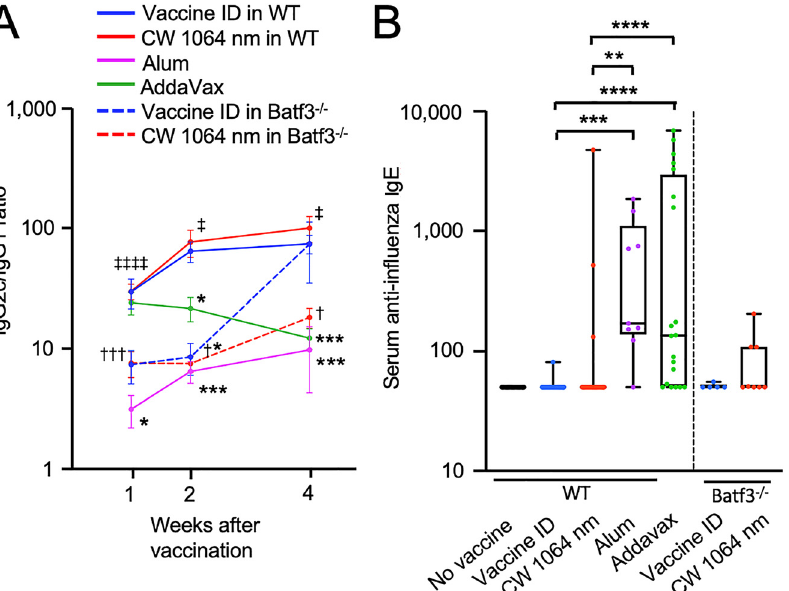
Figure4: TheeffectofNIRlaserandchemicaladjuvantsonIgEresponse.ThequalitativechangesintheimmuneresponsetotheNIRlaserand chemical adjuvants in the context of intradermal influenza vaccination were assessed in WT and Batf3 − / − mice. Serumanti-in fl uenzaspeci fi c (A)IgG2c/IgG1ratio,(B)IgEareshown.(A) n =30,38,34,14,25,5,8,(B) n =25,33,30,9,20,5,8fornovaccine, vaccineIDonlyinWT,vaccineID + NIRlaserinWT,vaccine + AlumID,vaccine + AddaVaxID,vaccineIDonlyinBatf3 − / − ,vaccineID +